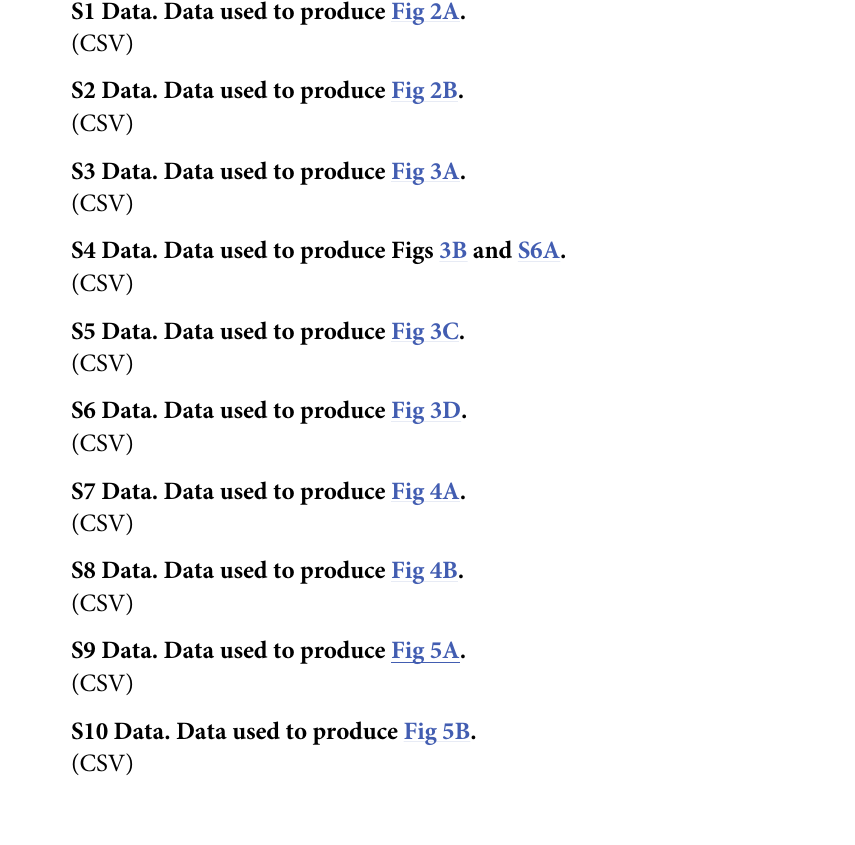
S16 Fig. Removal of low-count features results in an increasing proportion of anti-conser- vative p-value histograms. (A) Anti-conservative p -value histogram proportions in raw and filtered p -value sets for DE analysis programs. Raw p -value data is the same as in S5A Fig. Fil- tered p -value data is from a simple Bernoulli model [anticons ~ de_tool], N = 3,426. The data files are in S13 Data and in S14 Data (for raw data). (B) Effect size of low-count feature filtering to proportion of anti-conservative p -values. The data files are in S13 Data and in S14 Data (for raw data). (C) π estimates for raw and filtered p -value sets. Raw p -value data is the same as in 0 S6A Fig and filtered p -value data is from the beta model [pi0 ~ de_tool], N = 2,042. The data files are in S15 Data and in S16 Data (for raw data). (D) Effect size of low-count feature filter- ing to π . The data files are in S15 Data and in S16 Data (for raw data). Points denote model 0 best fit. Thick and thin lines denote 66% and 95% CIs, respectively. (TIFF) S17 Fig. Simulated RNA-seq data shows that histograms from p-value sets with around 100 true effects out of 20,000 features can be classified as “uniform”. RNA-seq data was simulated with polyester R package on 20,000 transcripts from human transcriptome using grid of 3, 6, and 10 replicates and 100, 200, 400, and 800 effects for 2 groups. Fold changes were set to 0.5 and 2. Differential expression was assessed using DESeq2 R package using default settings and group 1 versus group 2 contrast. Effects denotes in facet labels the number of true effects and N denotes number of replicates. Red line denotes QC threshold used for dividing p histograms into discrete classes. Code and workflow used to run these simulations is available on Github: https://github.com/rstats-tartu/simulate-rnaseq. Raw data of the figure is available on Zenodo https://zenodo.org with doi: 10.5281/zenodo.4463803. (TIFF) S1 Data. Data used to produce Fig 2A. (CSV) S2 Data. Data used to produce Fig 2B. (CSV) S3 Data. Data used to produce Fig 3A. (CSV) S4 Data. Data used to produce Figs 3B and S6A. (CSV) S5 Data. Data used to produce Fig 3C. (CSV) S6 Data. Data used to produce Fig 3D. (CSV) S7 Data. Data used to produce Fig 4A. (CSV) S8 Data. Data used to produce Fig 4B. (CSV) S9 Data. Data used to produce Fig 5A. (CSV) S10 Data. Data used to produce Fig 5B.